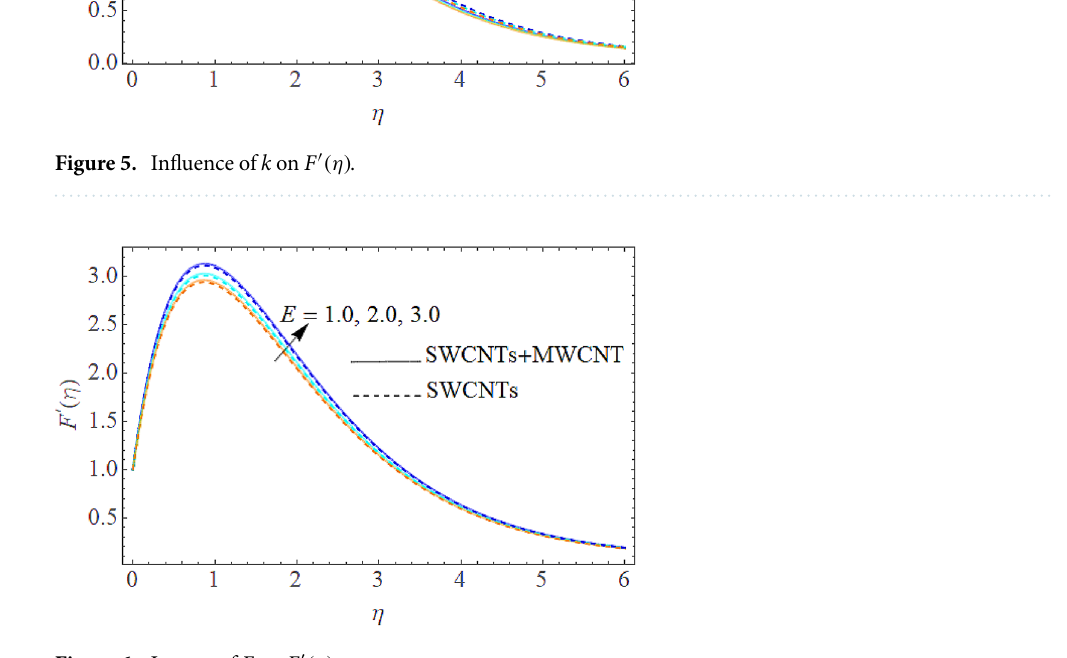
Figure 6. Impact of E on F ′ (η)